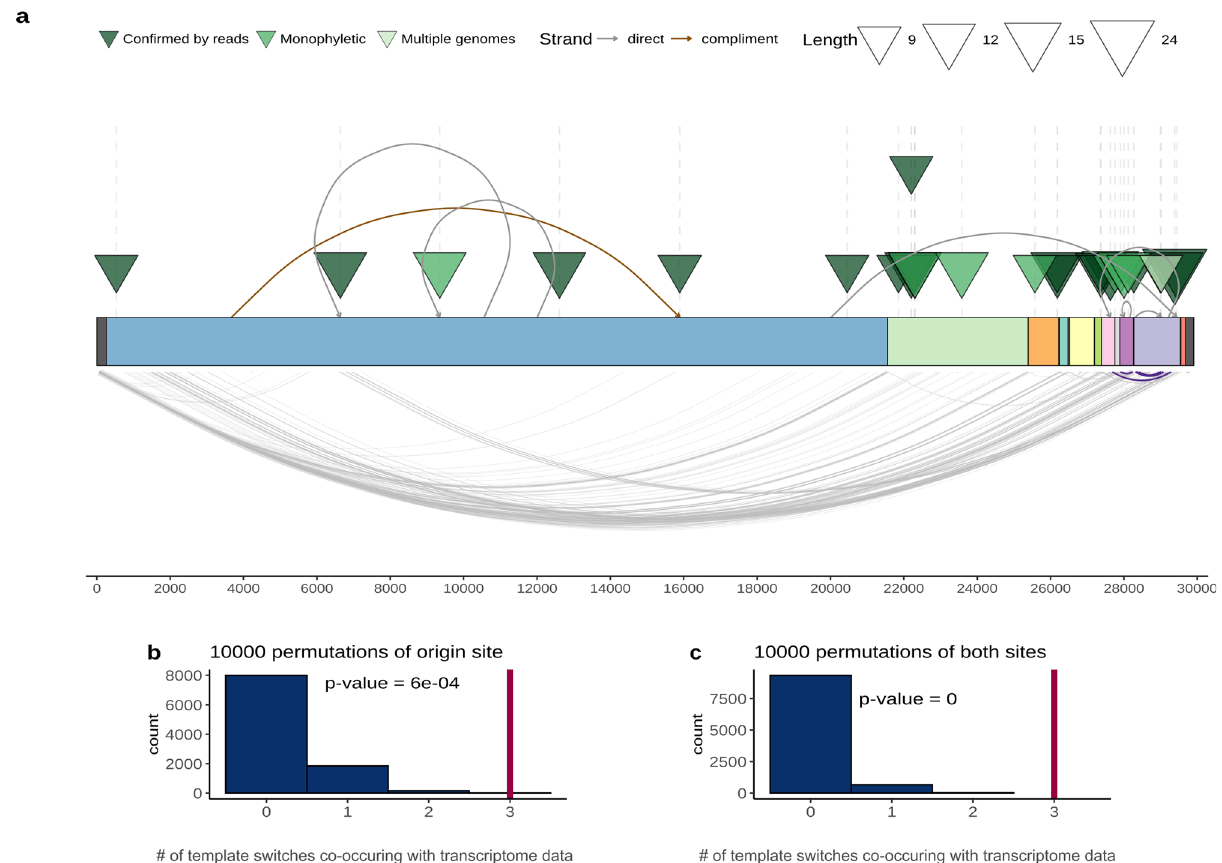
Fig. 2 Long insertions possibly occur through template switching and formation of nc sgRNAs. a Each triangle shows an independent insertion event, colored as in Fig. 1. Curves on the upper side of the plot connect the insertion origin site and insertion position, brown color indicates that the origin sequence is on the same strand, and gray color shows that the origin sequence is on complementary strand, curves at the bottom of the plot represent the experimental data on sgRNAs from Kim et al. 26 . Curves highlighted in violet correspond to the three cases when insert and corresponding origin site co- occur with sgRNA junctions. The SARS-CoV-2 genes are colored as in Fig. 1. Permutation tests show the number of template switches co-occurring with RdRp jumps ( x -axis) expected at random (blue), ( b ) when only the positions of the origins were randomly sampled 10,000 times from the genome; c when both ends were randomly sampled. Red vertical line represents the number observed in data. The code to reproduce the permutation tests is available in repository (see Code